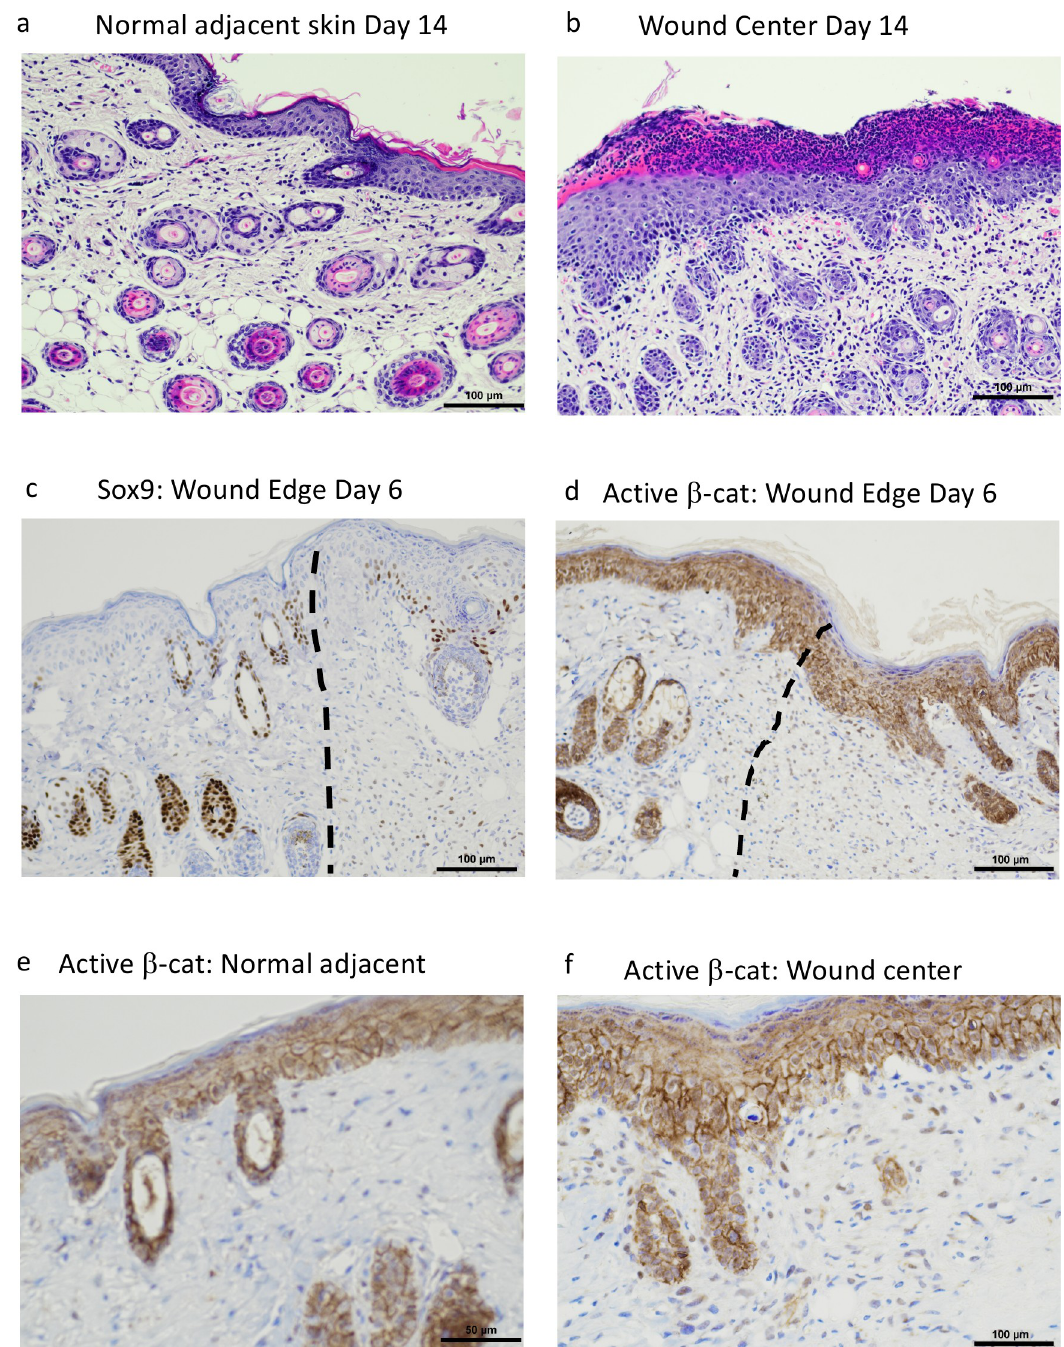
Fig 6. Evidence of hair follicle neogenesis. (a and b) Skin adjacent to a wound demonstrates growth of normal hair follicles and sebaceous glands, embedding in the subcutaneous adipose tissue whereas skin in the center of the wound demonstrates regeneration of many hair follicles, some with sebaceous glands with random orientation in the dermis, directly underlying a hyperplastic, recently reepithelialized epidermis. (c and d) Sox9 and active β -catenin immunohistochemistry showed adjacent skin with typical appearance of hair follicles (left of dotted lines) and wounded tissue (right of dotted lines) with atypical hair follicles and germs expressing Sox9 and active β -catenin in different orientation from normal hair follicles. (e and f) High power view showing the distinct appearance of hair follicles in normal adjacent skin (e) and within the center of a wound (f).